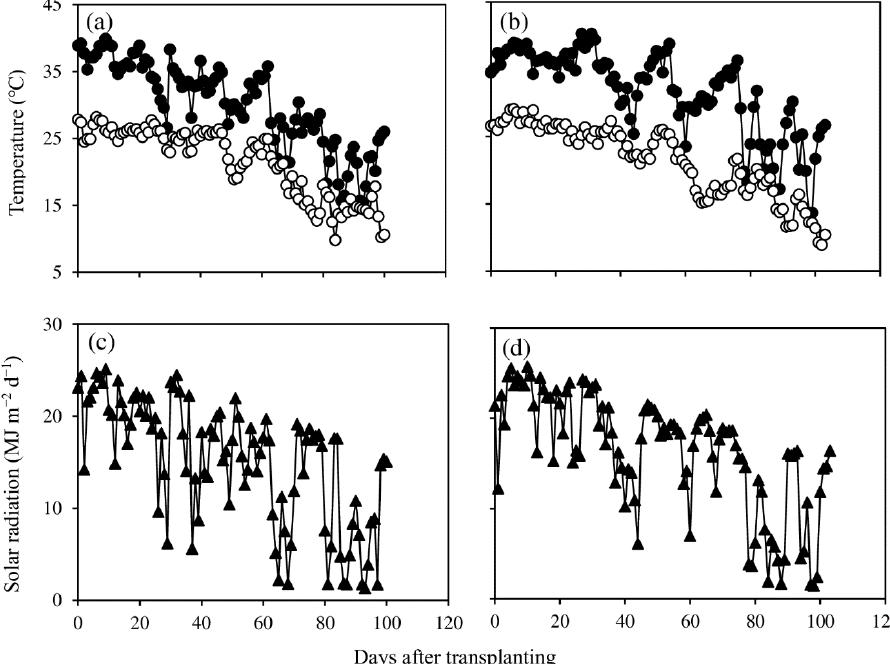
Figure 1. Daily maximum temperature (●), minimum temperature ( ○ ), and solar radiation ( ▲ ) in 2018 ( a , c ) and 2019 ( b , d ).